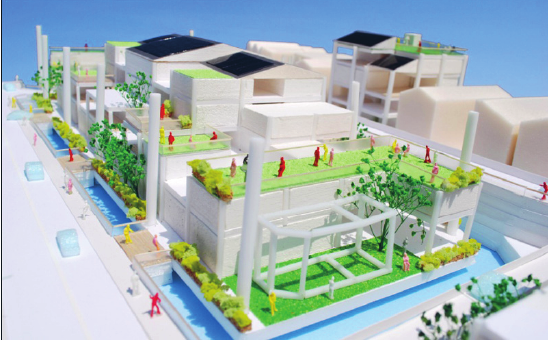
Figure 17. Sectional views of the conditions of floating platform both before and after constructions.